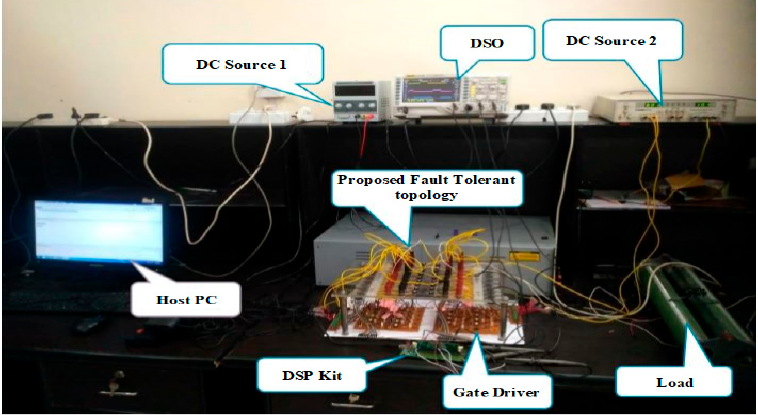
Figure 9. Experimental setup for the proposed fault-tolerant topology.